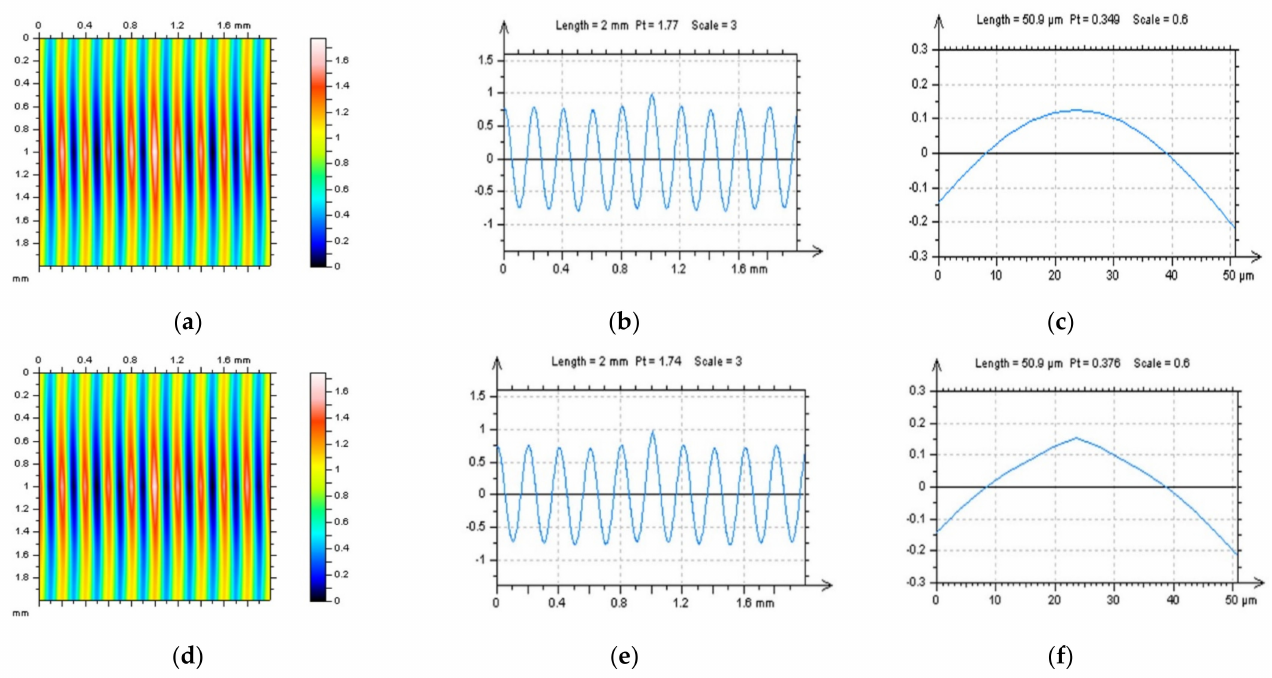
Figure 5. ACFs of turned surface (left column), (middle column) extracted from the middle of the ACF surface graph, of their profiles, and zoomed centries of those functions (right column), received from the measured surface ( a – c ) and surface with a high-frequency measurement error ( d – f